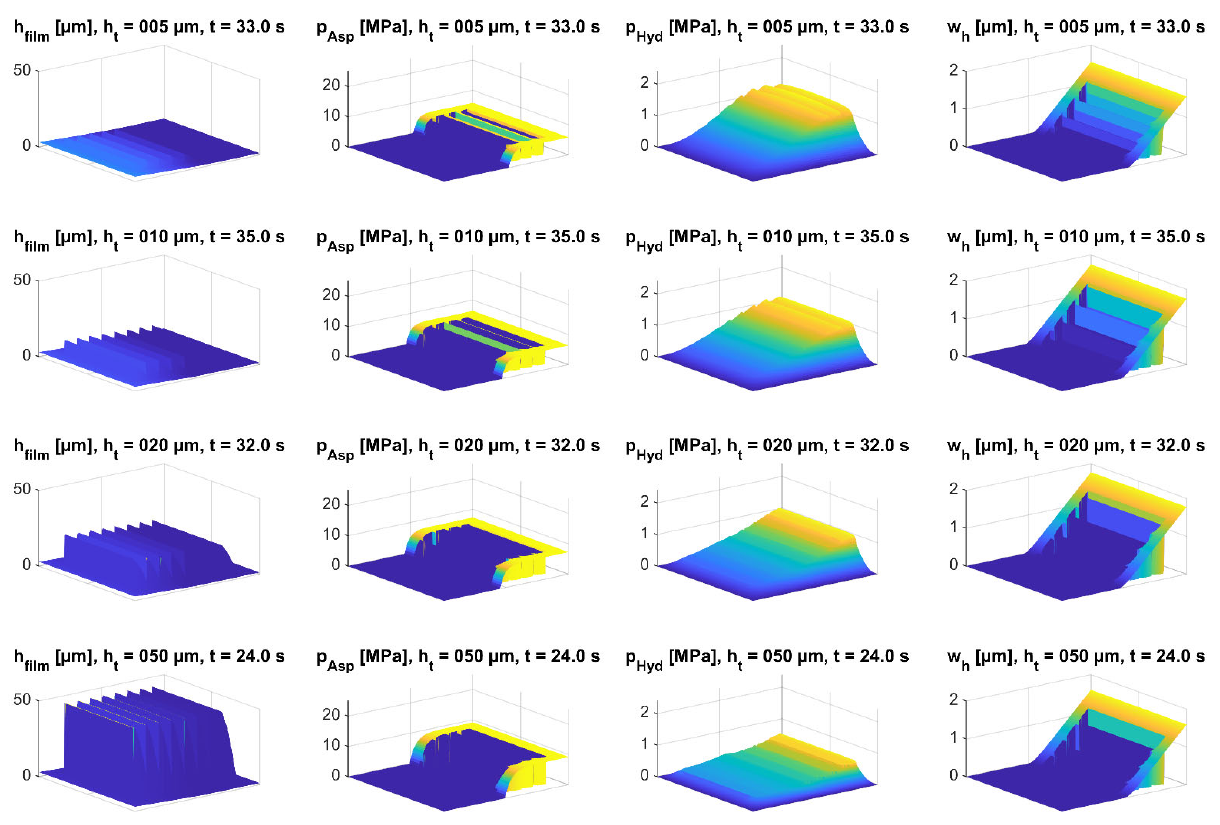
Figure 11. Surface plots for the wear dependent lubrication gap height, asperity contact pressure, hydrodynamic pressure, and wear height at the reversal point . Rosenkranz et al. [42] discussed the influence of the texture position in the lubrication wedge for different convergence ratios K ( 𝐾 (cid:3404)